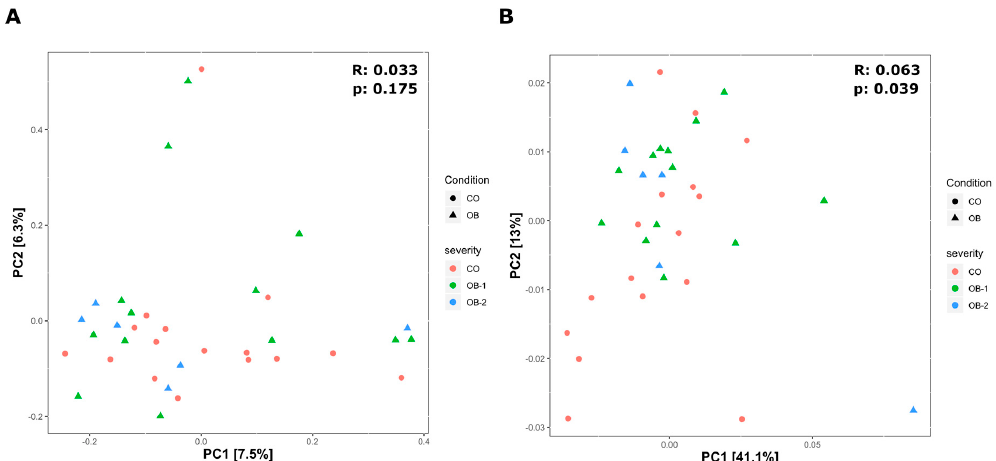
Figure 2. Beta diversity of bacteria identified in the Control (CO), Moderately Obese (OB-1) and Severely Obese (OB-2) groups. Principal coordinate analysis (PCoA) plots using the unweighted ( A ) and weighted (B) UniFrac distance measures. Statistical significance of groupings was assessed by the analysis of similarities (ANOSIM), which test whether there is a significant difference between groups. Only in the case of the weighted Unifrac ( B ) we got a significant result for CO and OB groups (UNWEIGHTED: p = 0.175, R = 0.033; WEIGHTED: p = 0.039, R = 0.063), confirming that the variation between two main groups is not due to the type of taxa present in the microbiome but to their abundances.